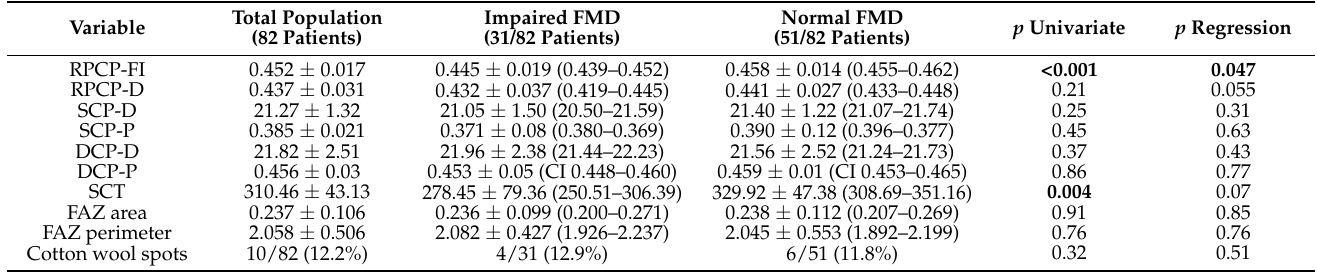
Figure 7. Subfoveal choroidal thickness (SCT) values in the impaired flow-mediated dilation (FMD) and normal FMD subgroups. Box plot showing the distribution of the SCT values in the impaired FMD and normal FMD subgroups. Table 3. Retinal vascular OCT and OCTA parameters in the total study population (82 patients), the impaired flow-mediated dilation (FMD) subgroup (31 patients), and the normal FMD subgroup (51 patients). The last two columns on the right show the p values derived from univariate analysis and the p values derived from binary logistic regression comparing the two mentioned subgroups. Both univariate and binary logistic regression analysis showed that RPCP-FI was significantly lower in impaired FMD subjects ( p value in bold). From the univariate analysis, SCT was found to be lower in patients with impaired FMD (reported in bold), while this resulted only as a trend in binary logistic regression